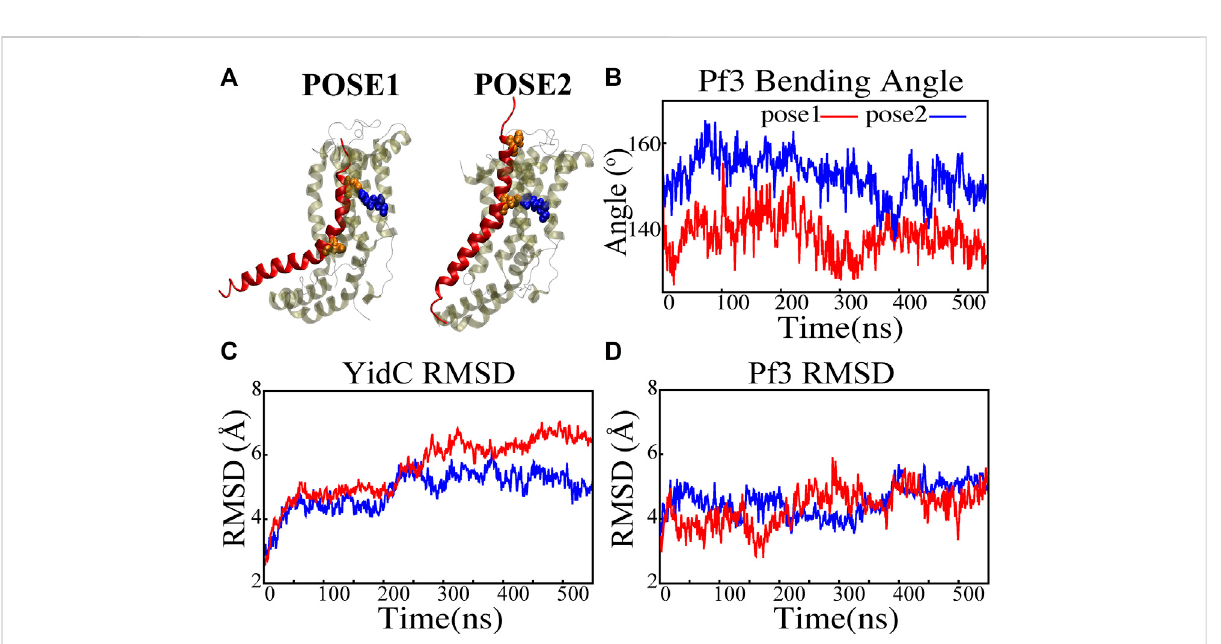
FIGURE 2 Structural stability evaluation of YidC and Pf3 coat protein in the insertion process. (A) Cartoon representation of pose1 and pose2 docking models generated based on the YidC (PDB:3WO7) Pf3 coat protein insertion process, as described previously in methods. (B) The bending angle of the Pf3 coat protein helix in pose1 (red) and pose2 (blue) models shown as a function of time. (C,D) Root mean square deviation of the YidC and Pf3 coat protein in pose1 (red) and pose2 (blue) models. Based on RMSD results, we have observed that in pose2 stage the YidC is signi fi cantly more stable compared to the pose1